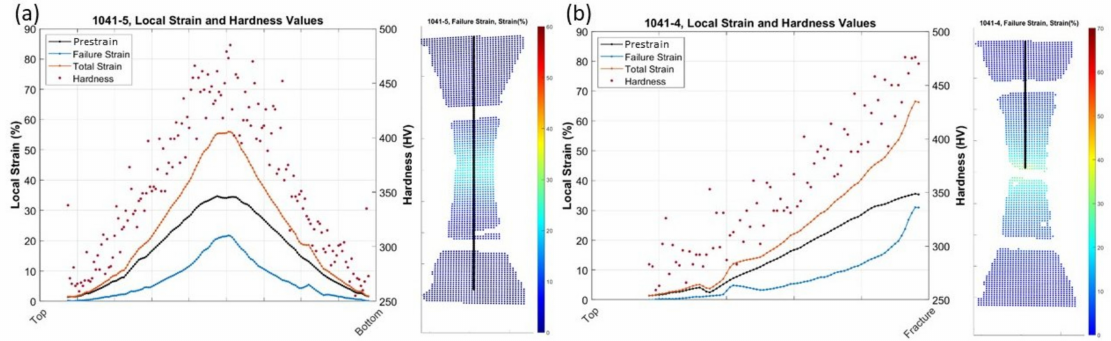
Figure 11. Local strain and hardness values with the correlating strain analysis and hardness indentation. ( a ) shows a specimen brought to the maximum load prior to hardness testing, and ( b ) shows a specimen brought to failure prior to harness